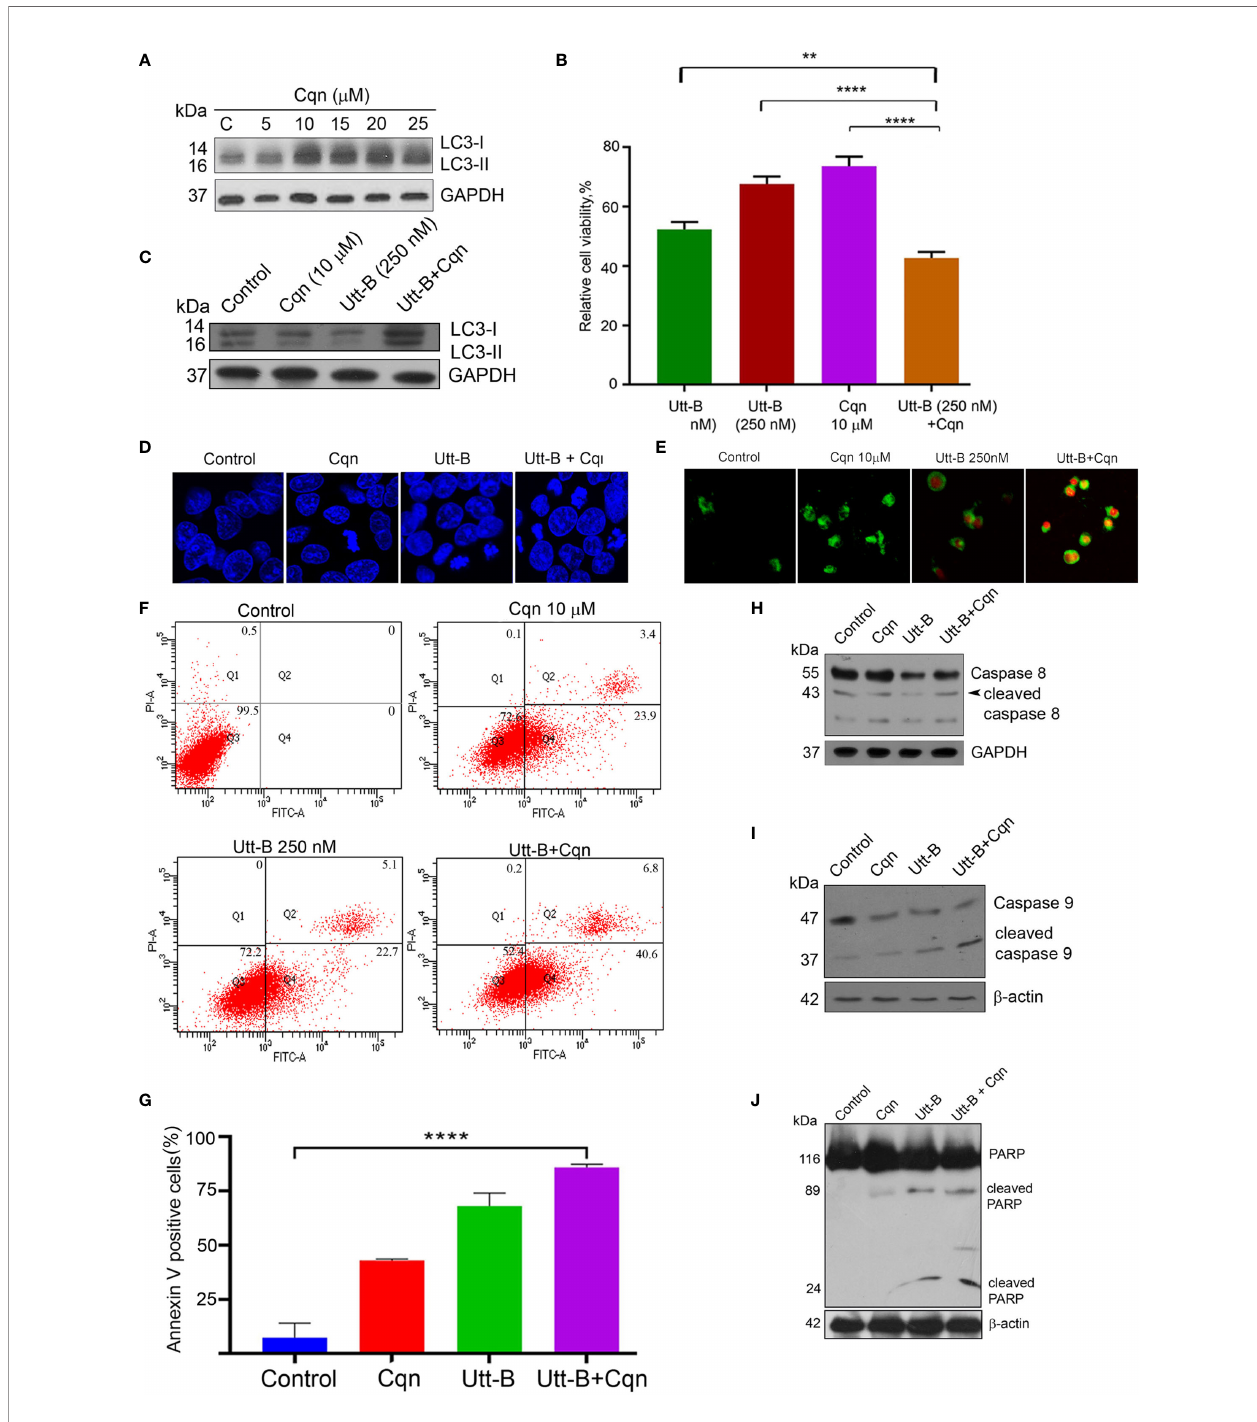
FIGURE 4 | Co-treatment of Cqn with Utt-B enhances the anti-cancer ef fi cacy of Utt-B, in vitro. (A) 10 µM Cqn blocks autophagy in HepG2 cells as shown by the accumulation of LC3-II. (B) Co-treatment of sub-toxic concentration of Cqn with Utt-B enhances the cytotoxicity of Utt-B, in HepG2 cells. (C) Co-treatment of a sub- toxic concentration of Cqn with Utt-B enhances the accumulation of LC3-II. (D) DAPI staining reveals that co-treatment of Cqn and Utt-B enhances the nuclear condensation of HepG2 cells. (E) Annexin-PI staining indicates an enhancement in apoptosis in the wells treated with the combination. (F, G) Annexin-PI fl ow cytometric analysis shows an increase in apoptotic cells in the co-treated cells. (H – J) Western blot analysis shows an enhancement in cleavage of caspase 8, caspase 9, and PARP in HepG2 cells treated with the combination of Cqn and Utt-B. ** level of signi fi cance 2, **** level of signi fi cance 4. The error bars represent the Standard Deviation. One-way ANOVA followed by Tukey ’ s post hoc t test analysis was used for statistical comparison between different groups. ****P ≤ 0.0001; **P ≤ 0.01, Symbol asterisk (*) represents statistical signi fi cance between control and treatment groups (B, G)